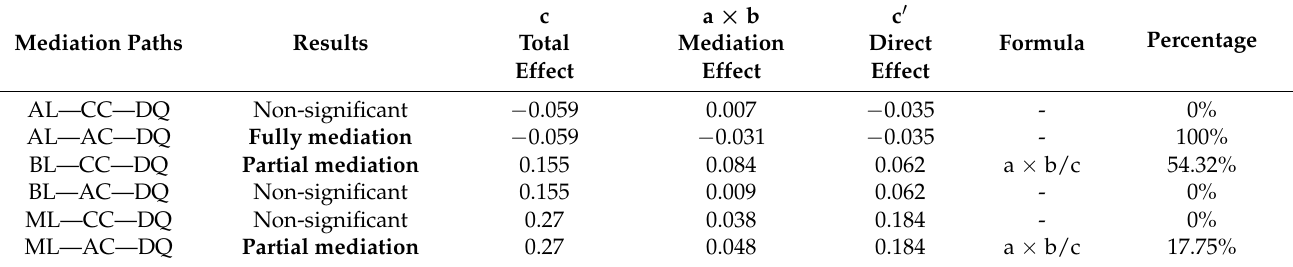
Table 4. Mediation Effect Test